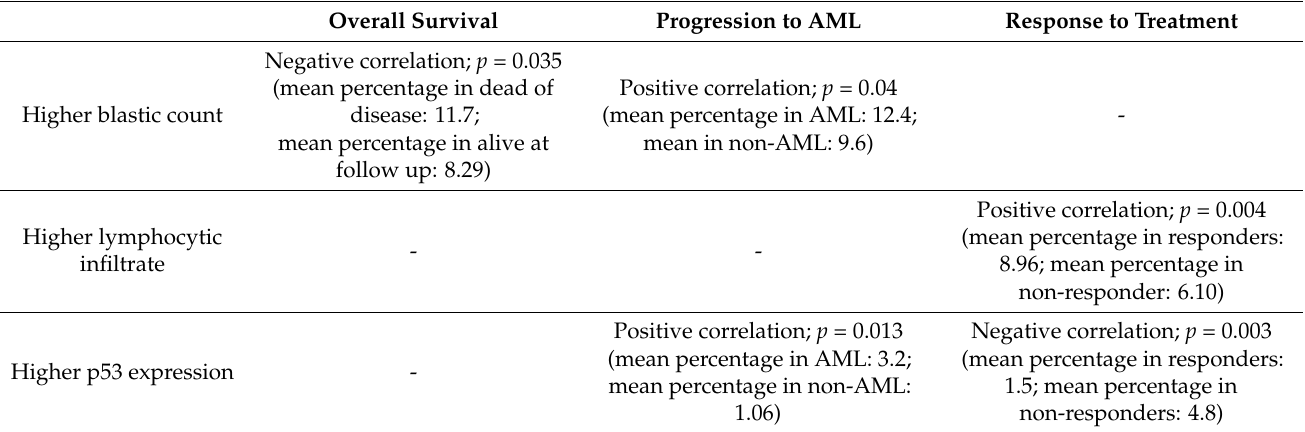
Table 5. Post-treatment